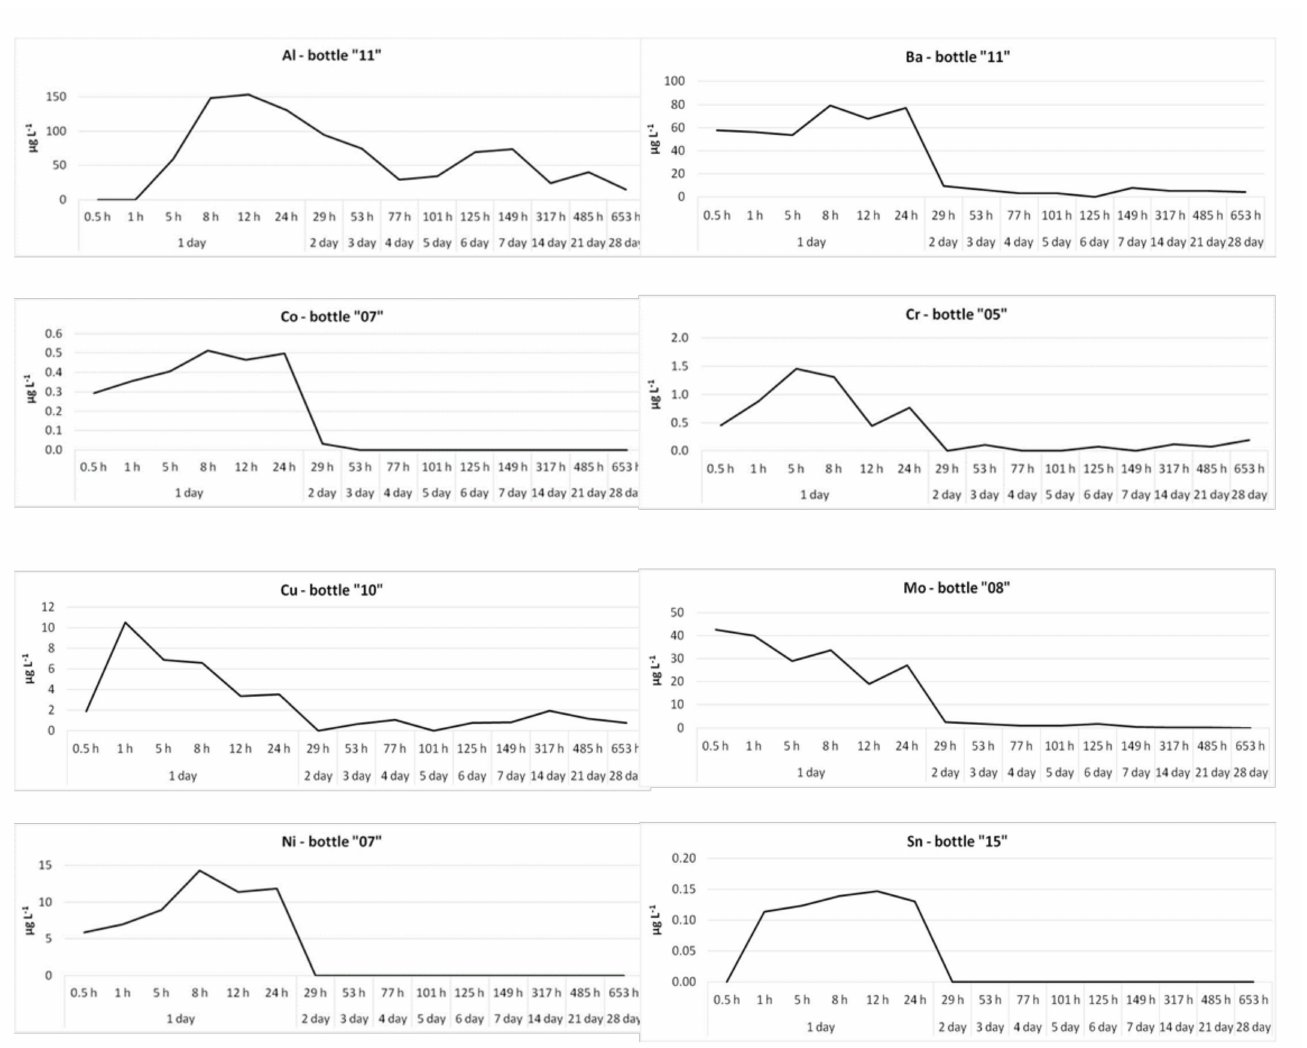
Figure 2. 28 days release trend for Al, Ba, Co, Cr, Cu, Mo, Ni, Sn for the bottle that presented the highest release for the specific